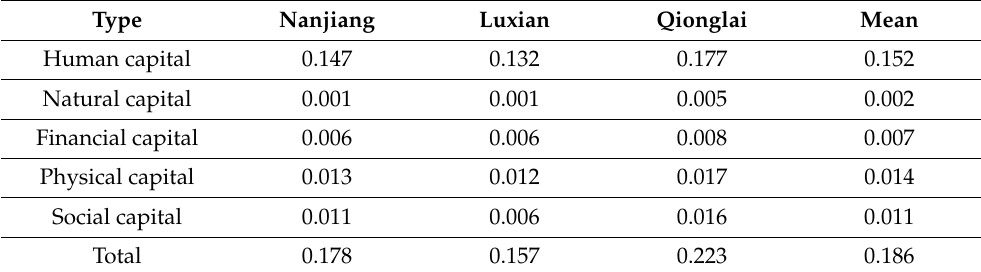
Table 3. Household livelihood capital values in the study areas. Type Nanjiang Luxian Qionglai Mean Human capital 0.147 0.132 0.177 0.152 Natural capital 0.001 0.001 0.005 0.002 Financial capital 0.006 0.006 0.008 0.007 Physical capital 0.013 0.012 0.017 0.014 Social capital 0.011 0.006 0.016 0.011 Total 0.178 0.157 0.223